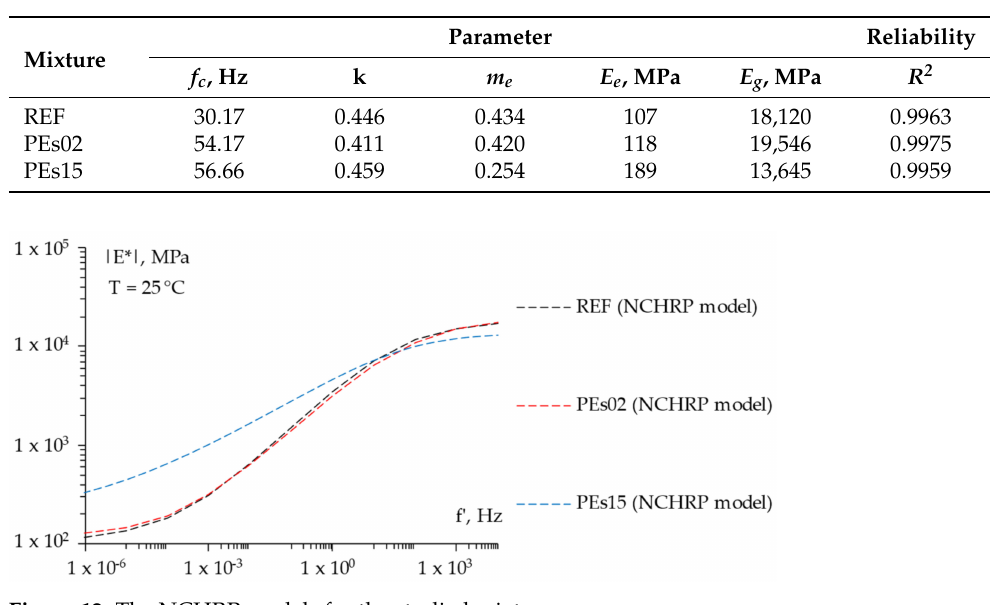
Figure 12. The NCHRP models for the studied